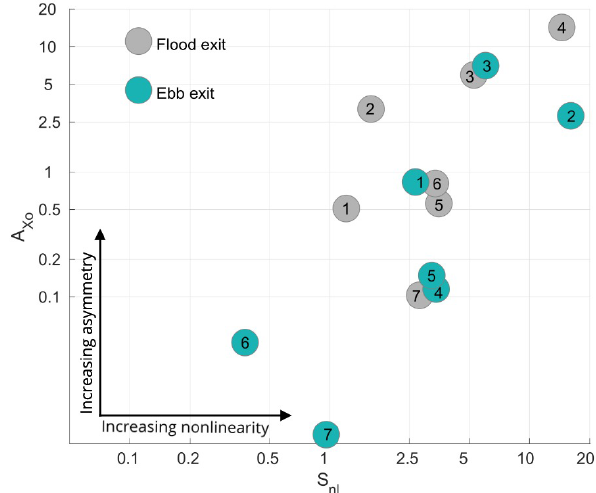
Figure 11. Estimates of the flow asymmetry A x o at the openings of each strait plotted against the non-linearity parameter S nl . Green dots are values at the flood exit (directed out of Vestfjorden), while light gray dots are values at the ebb exits (directed into Vestfjorden). Both parameters are plotted on log